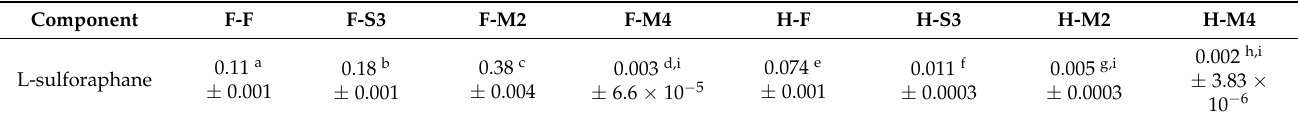
Table 3. Quantification of L-sulforaphane in broccoli extracts (F-F, F-S3, F-M2, F-M4, H-F, H-S3, H-M2, and H-M4) using